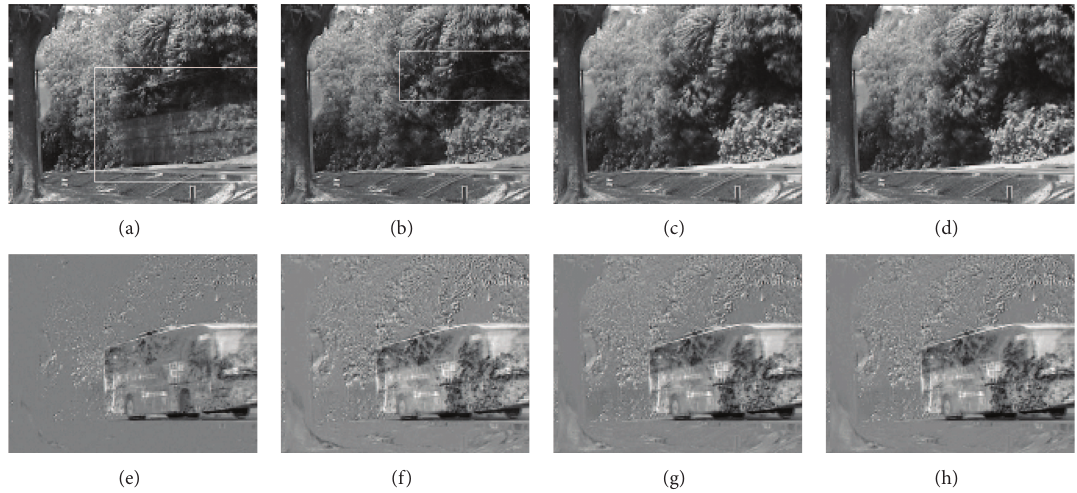
Figure 6: Campus: (a)–(d) background and (e)–(h) foreground from IALM, GoDec, NSMP, and WNSMP.